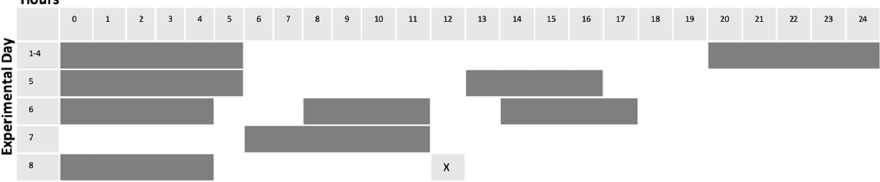
Figure 1. Scheme for alteration of light cycles. Gray bars indicate lights OFF, while white areas indicate lights ON.